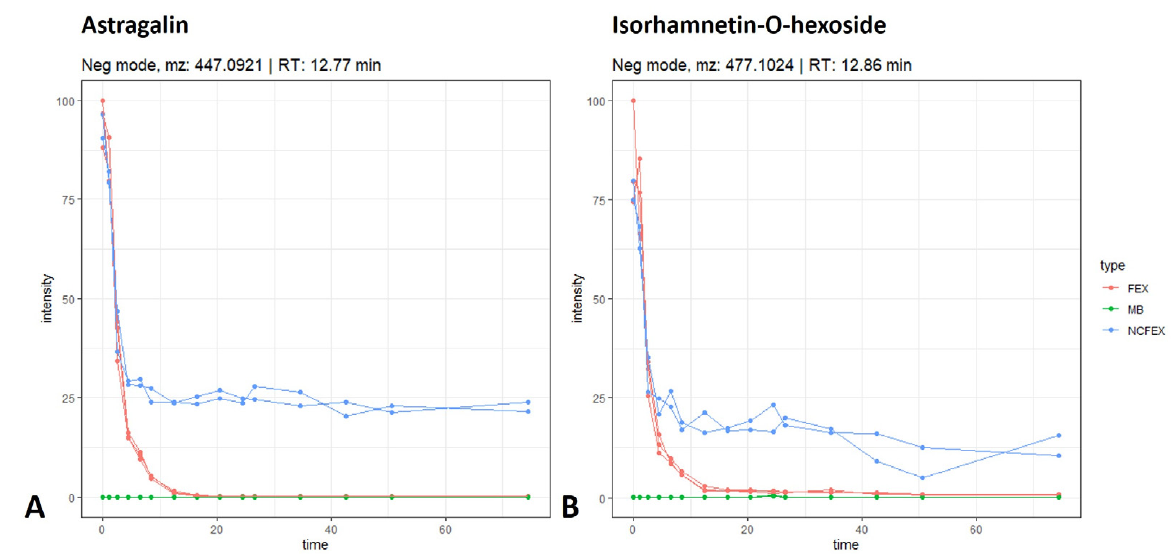
Figure 3. Time profiles (time in hours) of astragalin ( A ) and isorhamnetin-O-hexoside ( B ) during gastrointestinal biotransformation. See also legend of Figure 2.